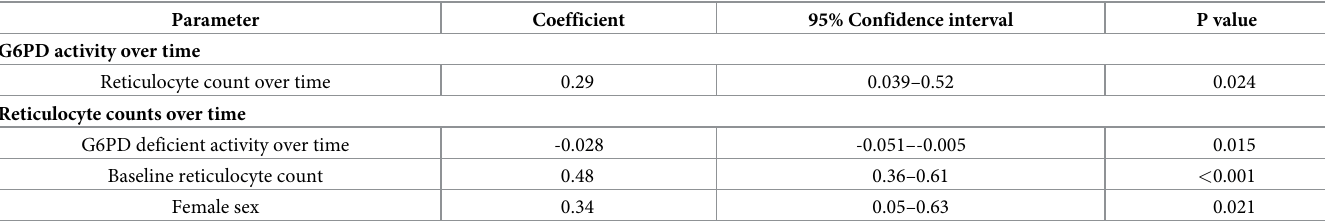
Table 2. Significant factors independently associated with G6PD activity over time and reticulocyte counts over time by multivariable